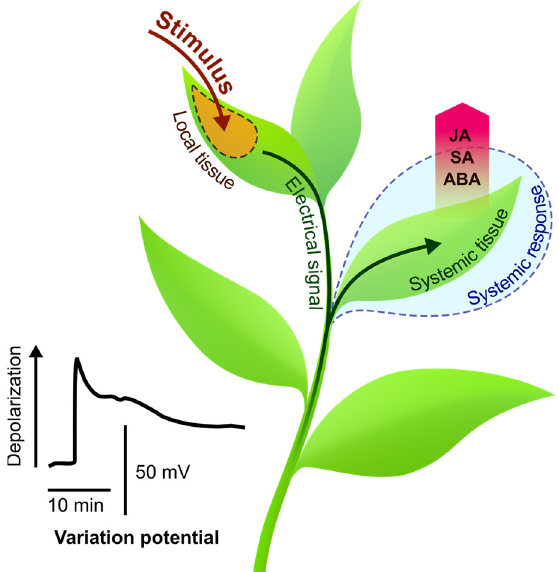
Figure 1. Long-distance electrical signal (e.g., variation potential) occurs in response to a local stimulus and propagates from the local tissue to the systemic tissue, where it controls stimulus-induced changes in hormone levels, and then the electrical signal and hormones together regulate stimulus-induced systemic response. ABA, abscisic acid; JA, jasmonic acid; SA, salicylic acid.